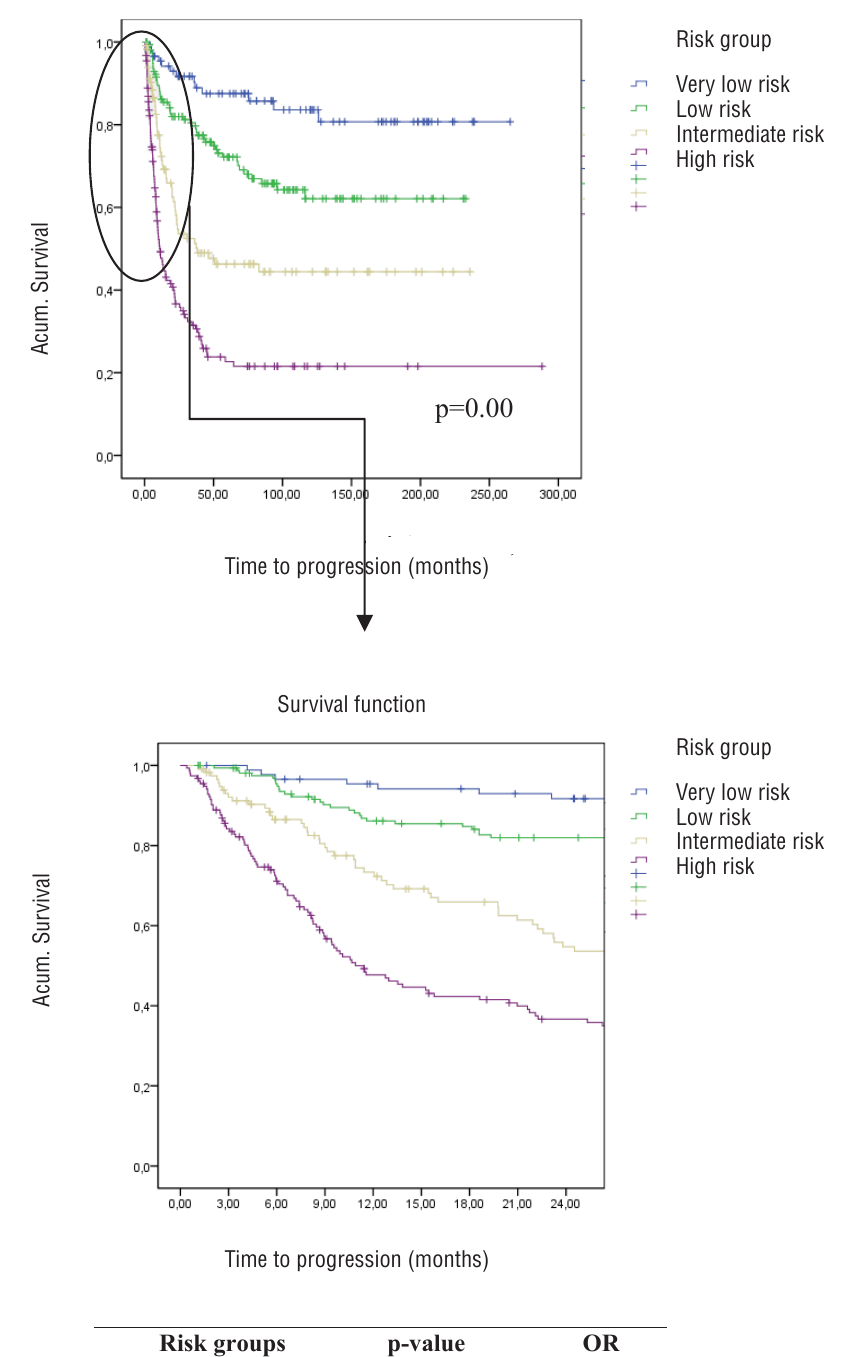
Figure 3 - PFS by risk